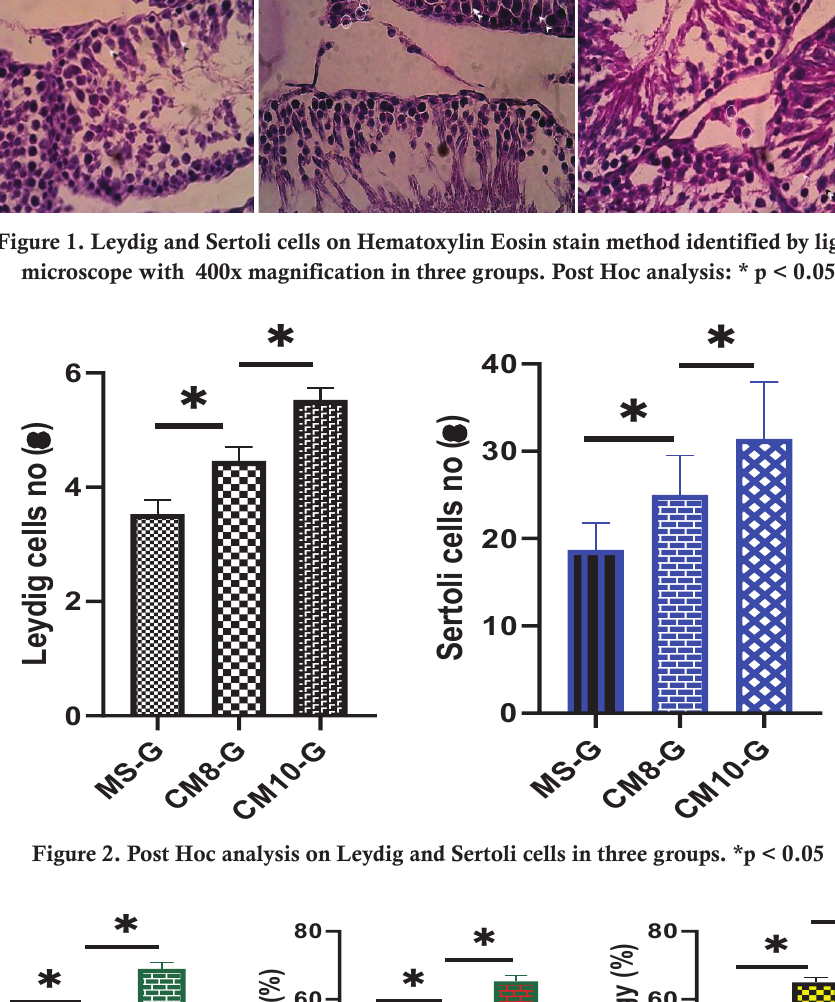
Figure 2 . Post Hoc analysis on Leydig and Sertoli cells in three groups. *p < 0.05